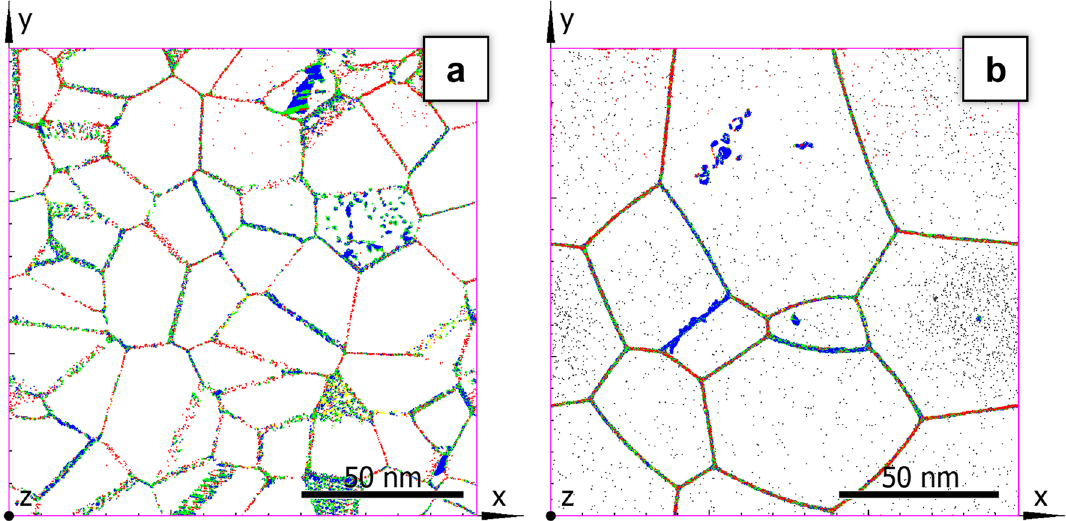
Figure 1. Nanocrystalline sample generated by Voronoi polyhedra filling (V-type sample): ( a ) just after the construction, ( b ) after 50 ns of annealing at T = 0.904 T m . Grain boundaries are of mixed colours, the blue colour is for atoms in stacking faults and stacking faults tetrahedra. Atoms belonging to the fcc structure are not